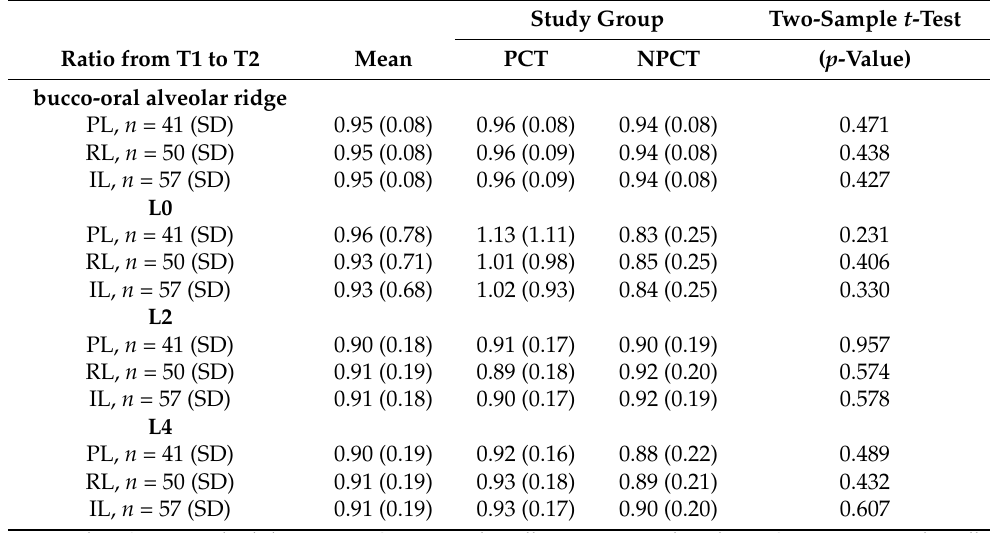
Table 5. Ratio of residual bone width of bucco-oral alveolar ridge and buccal lamella from T1 to T2. Study Group Two-Sample t